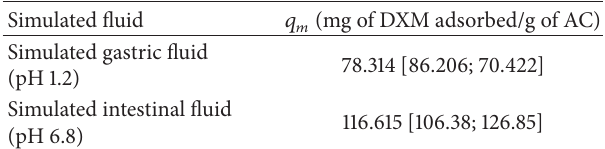
Table 1: Maximal adsorption capacity, 𝑞 𝑚 (mg DXM adsorbed/g of AC) in SGF and SIF.